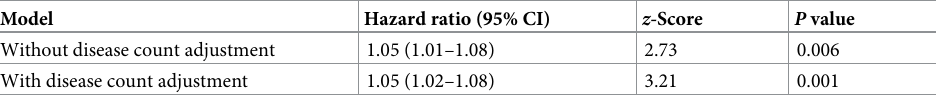
Table 4. Association between Phenotypic Age and all-cause mortality in oldest-old adults (aged 85+ years).